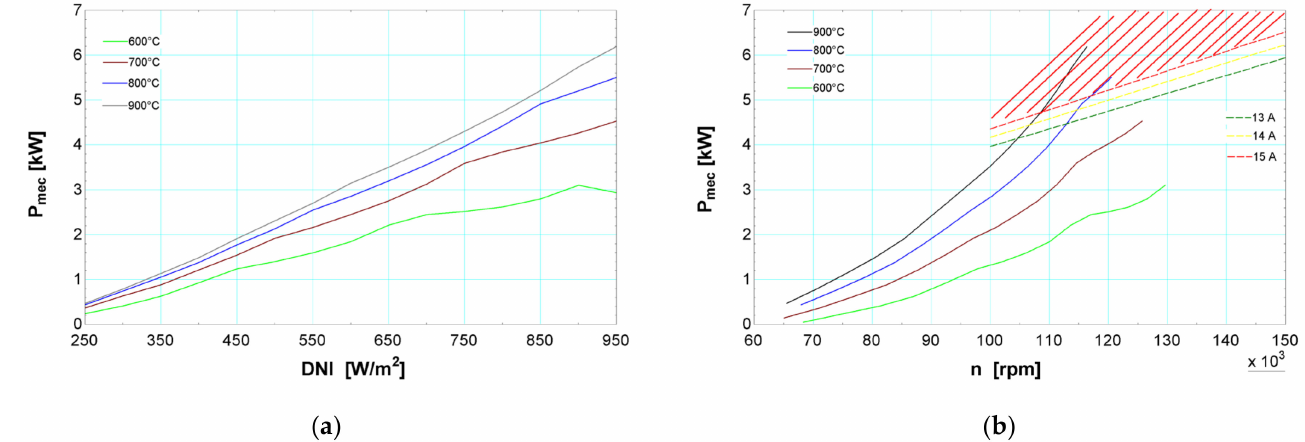
Figure 14. Example of parametric analysis: ( a ) mechanical power produced at different DNI varying the TIT; ( b ) mechanical power available at the shaft at different MGT speed rates varying the